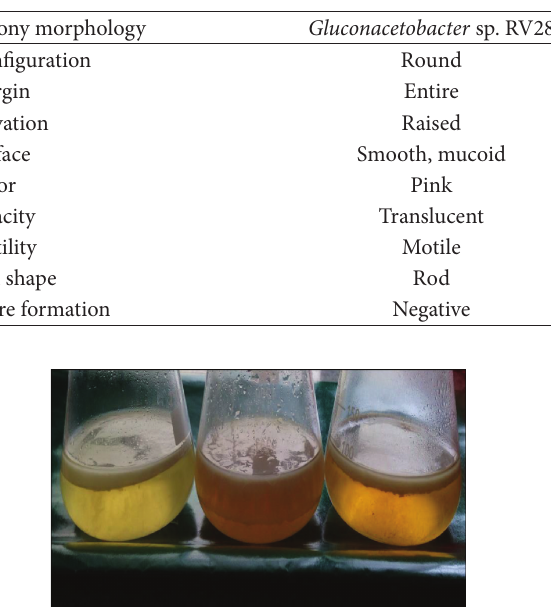
Table 3: Cultural characterization of Gluconacetobacter sp. RV28.